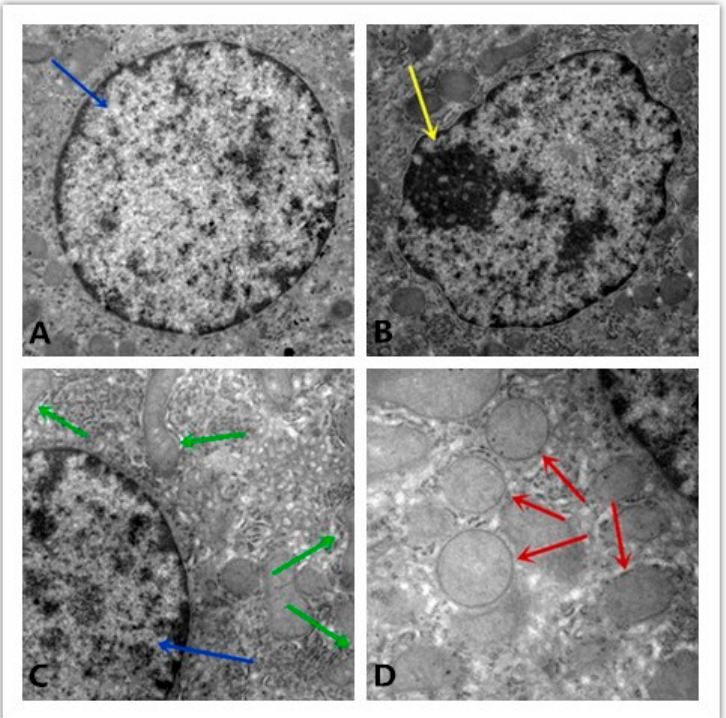
Figure 2. Liver ultrastructure observations. ( A ) Normal nucleus; ( B ) apoptosis nucleus; ( C ) normal mitochondria; ( D ) swelled mitochondria. The blue arrow shows a normal nucleus that contains